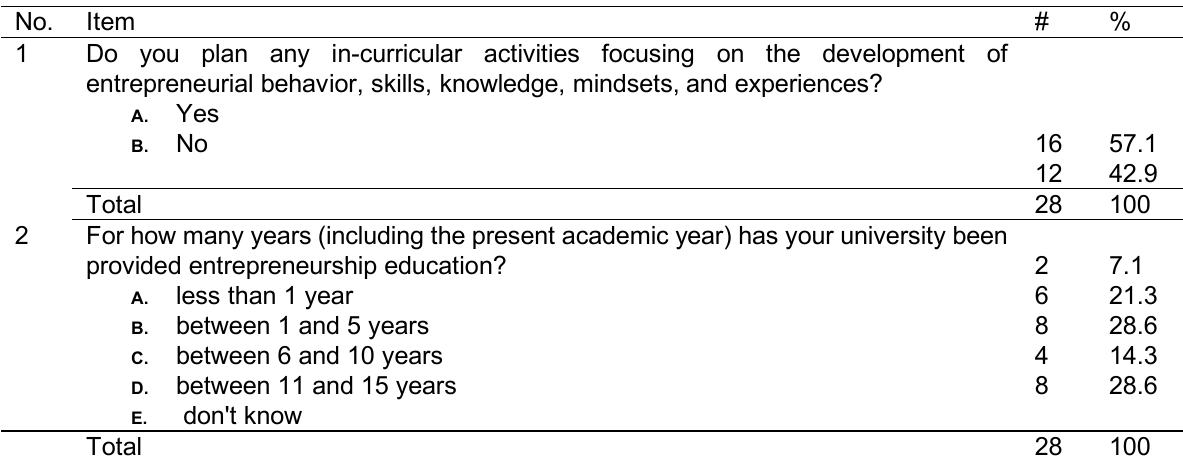
Table 2: Teachers plan and the university experience in providing entrepreneurship education No. Item #